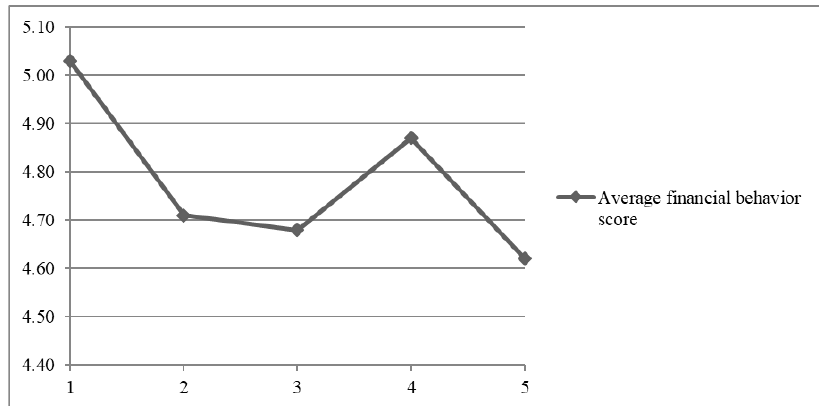
Figure 2: Average Financial Behavior Scores by Financial Attitude Score Financial